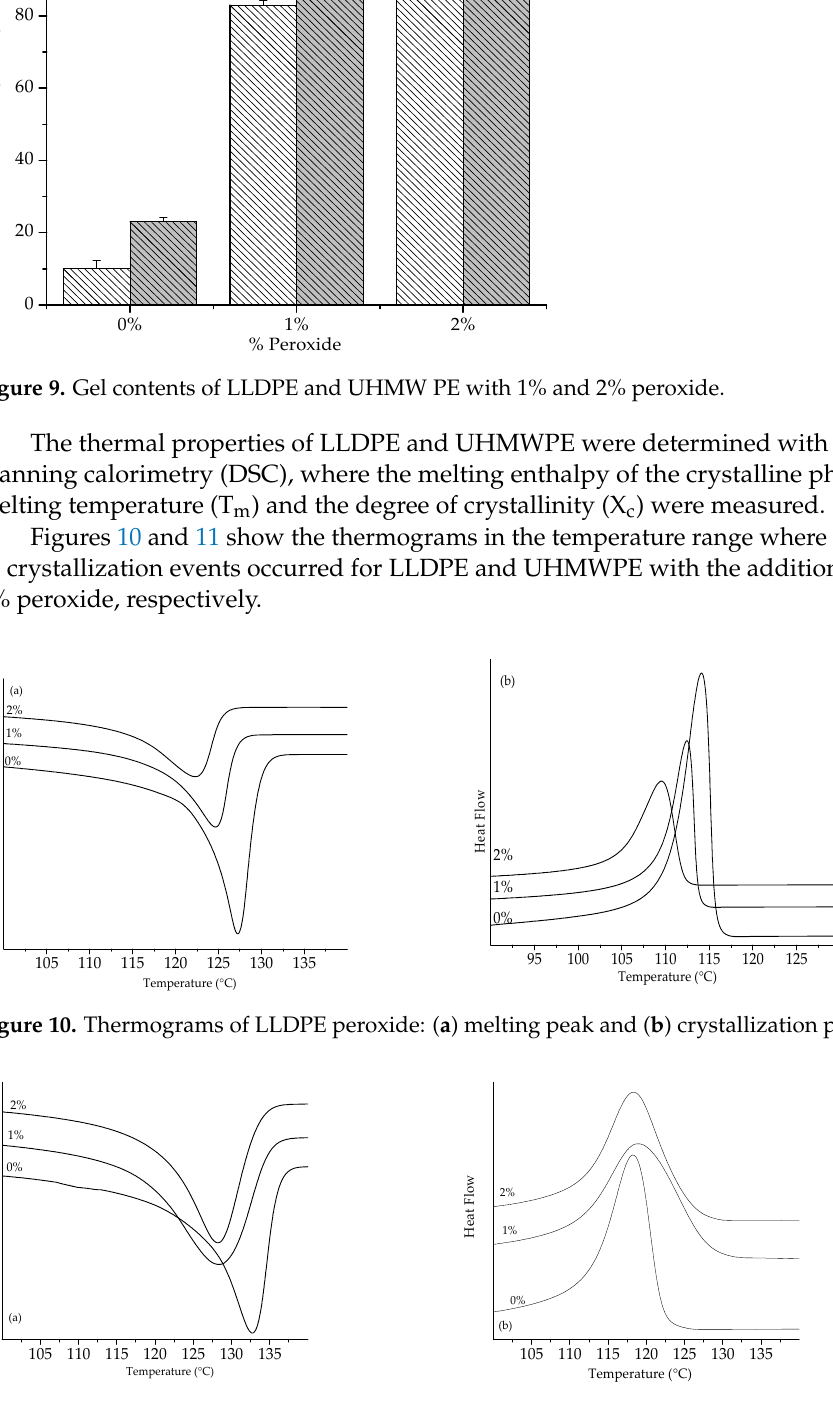
Figure 11. Thermograms of UHMWPE peroxide: ( a ) melting peak and ( b ) crystallization peak. The melting enthalpy decreased with the addition of 1% peroxide for the two analyzed polyethylenes and slightly increased again with the addition of 2% peroxide on heating, as shown in Table 1.